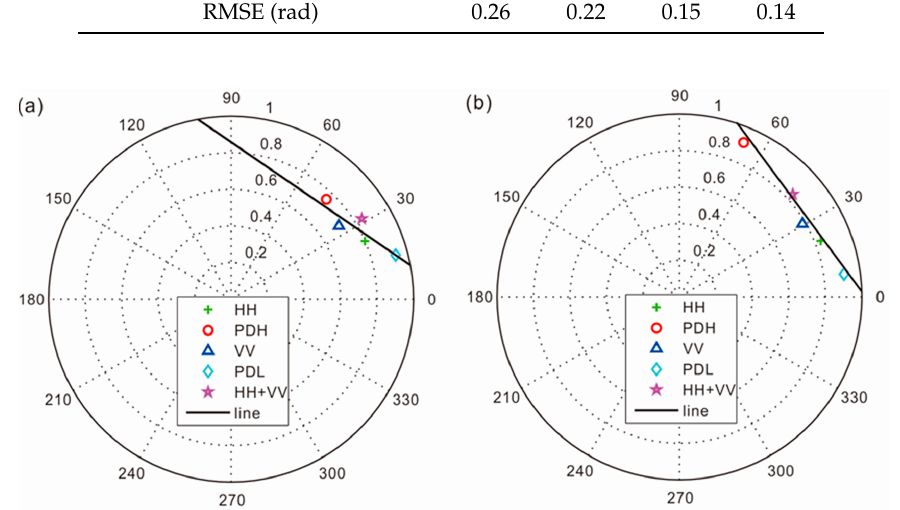
Figure 7. The coherence line fitted by using the total least squares linear fitting method. ( a ) Low density; ( b ) high density.